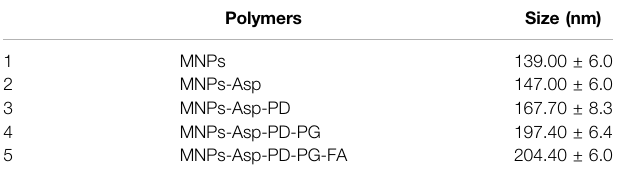
Frontiers in Molecular Biosciences |